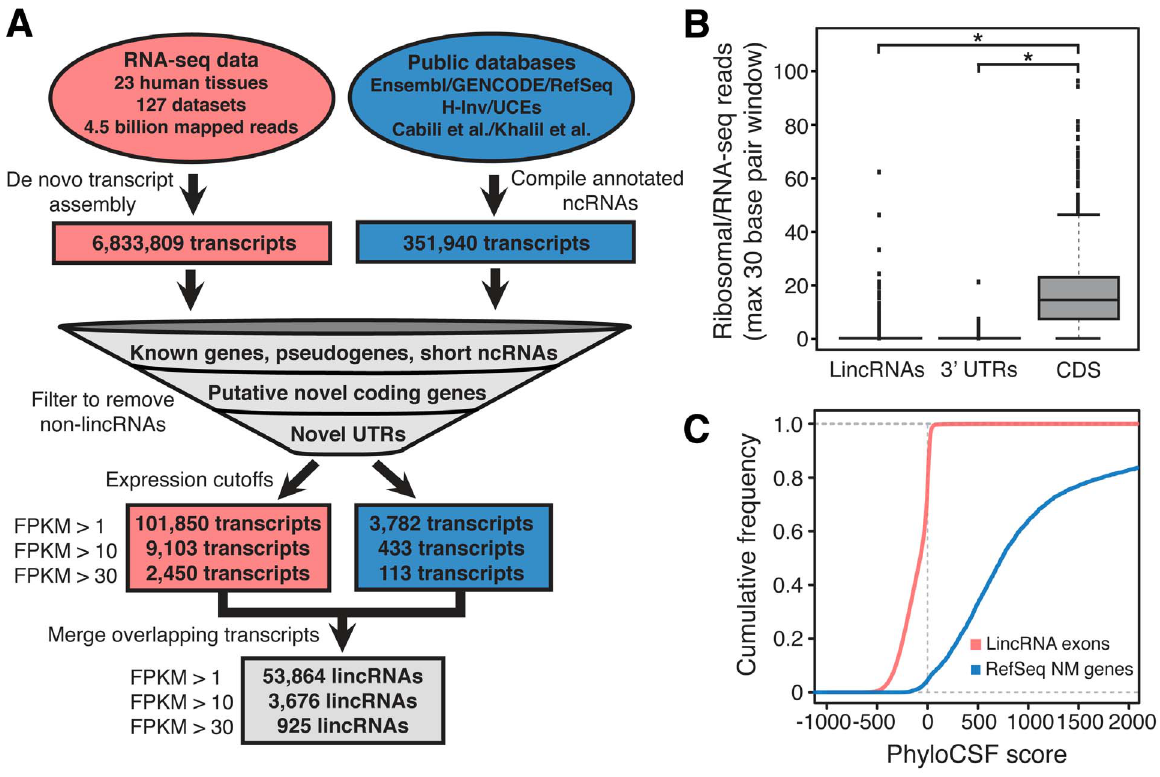
Figure 2. Discovery of lincRNAs. (A) Discovery of lincRNAs consisted of de novo assembly of transcripts from RNA-seq data and compilation of annotated and putative noncoding RNAs (see Methods), followed by a series of filters designed to remove all known and novel protein coding transcripts and non-lincRNA noncoding RNAs. Only intergenic noncoding transcripts at least 200 nucleotides in length and expressed at least at one copy per cell were ultimately annotated as lincRNAs. (B) Analysis of ribosomal profiling data reveals that the lincRNA catalog is composed of noncoding transcripts. The maximum 30 bp window ratio of HeLa ribosomal/RNA-seq reads [22] is plotted for exons of lincRNAs, 3 9 UTRs and coding sequences (CDS). * P , 2.2E-16; whiskers extend + / 2 1.5 times interquartile range and dots represent outliers. (C) Computational analysis of protein coding capacity of the lincRNAs reveals a lack of protein coding capacity. The cumulative distribution of PhyloCSF [40] scores for lincRNAs and RefSeq NM genes are plotted. Higher scores correspond to higher predicted coding capacity. (Figure 3A). Activating histone marks, H3K4me3 and H3K36me3, are both significantly enriched within highly expressed lincRNAs. Similarly, the repressive mark H3K27me3 is significantly enriched within lowly expressed lincRNAs. Thus, the expression of lincRNAs appears to be specifically regulated.